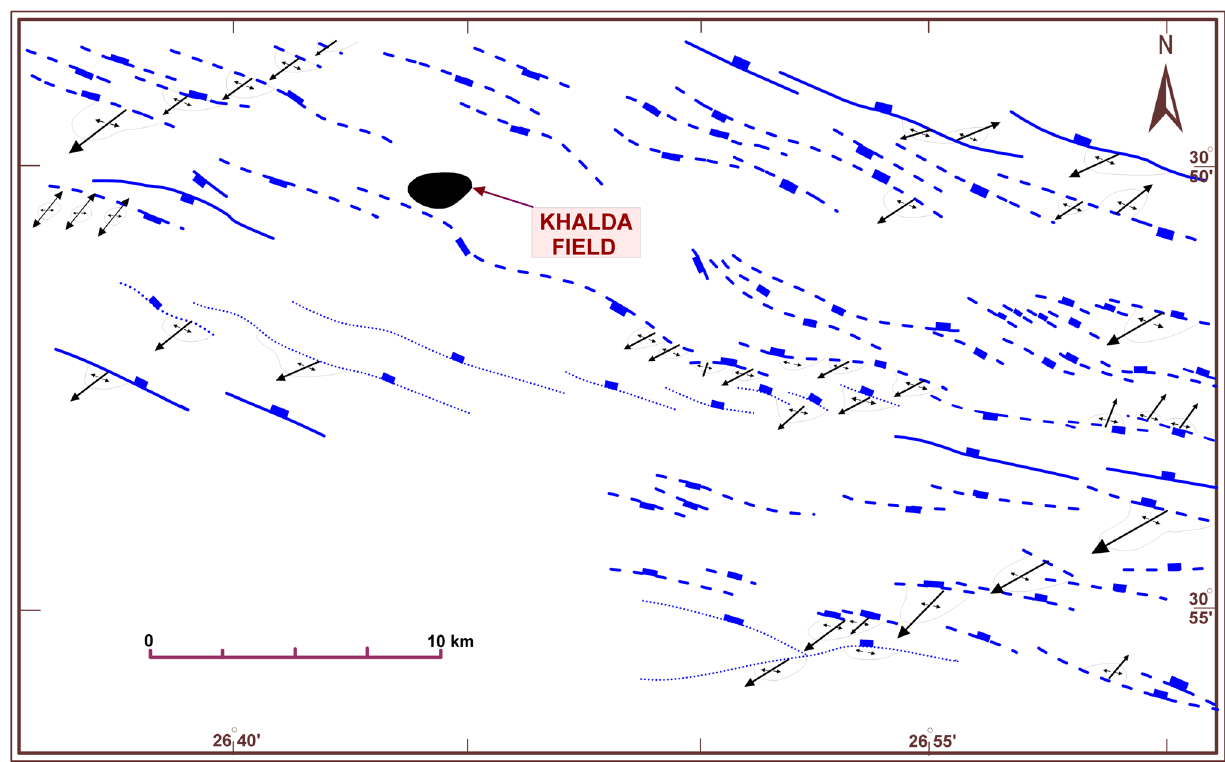
Fig. 3 Structural sketch map for the Khalda Concession showing the main faults and structural closures at the top of the Cenomanian Bahariya sequence (Sehim et al.